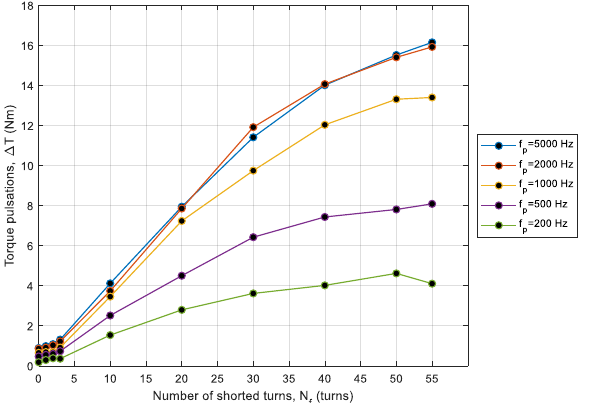
Figure 15. Torque ripple factor as a function of shorted turns N f in the case of a faulty motor, at T L = 0 Nm.